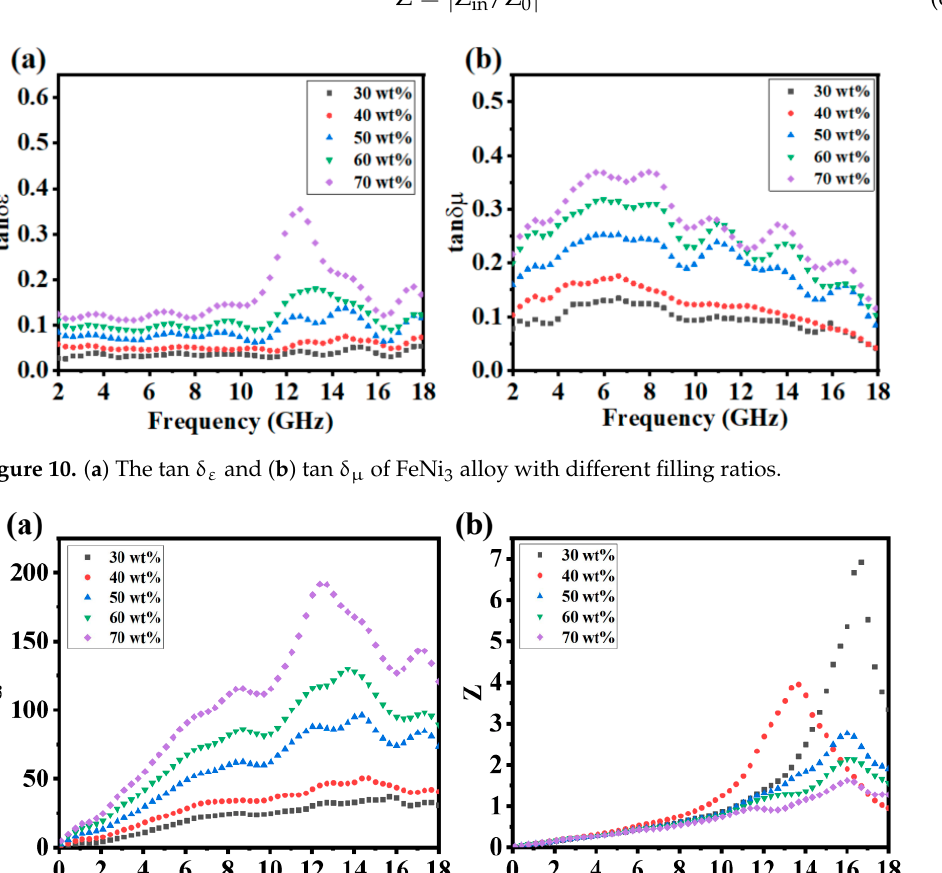
Figure 11. ( a ) Attenuation constant and ( b ) relative input impedance of FeNi 3 alloy sample with 30–70 wt% filling ratios.